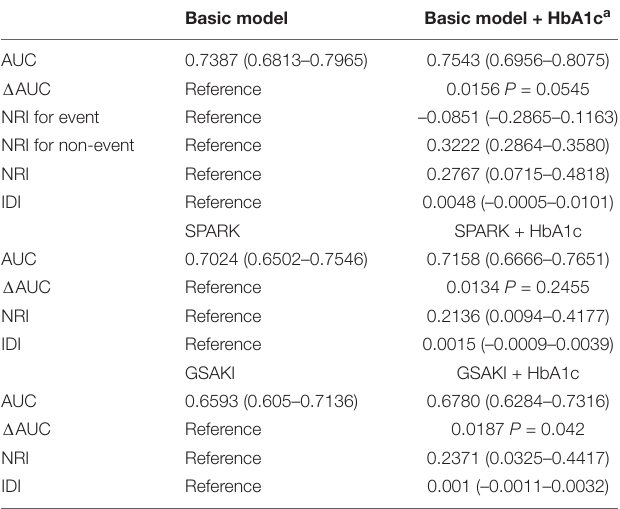
TABLE 3 | Performance metrics of acute kidney injury prediction models with and without glycosylated hemoglobin